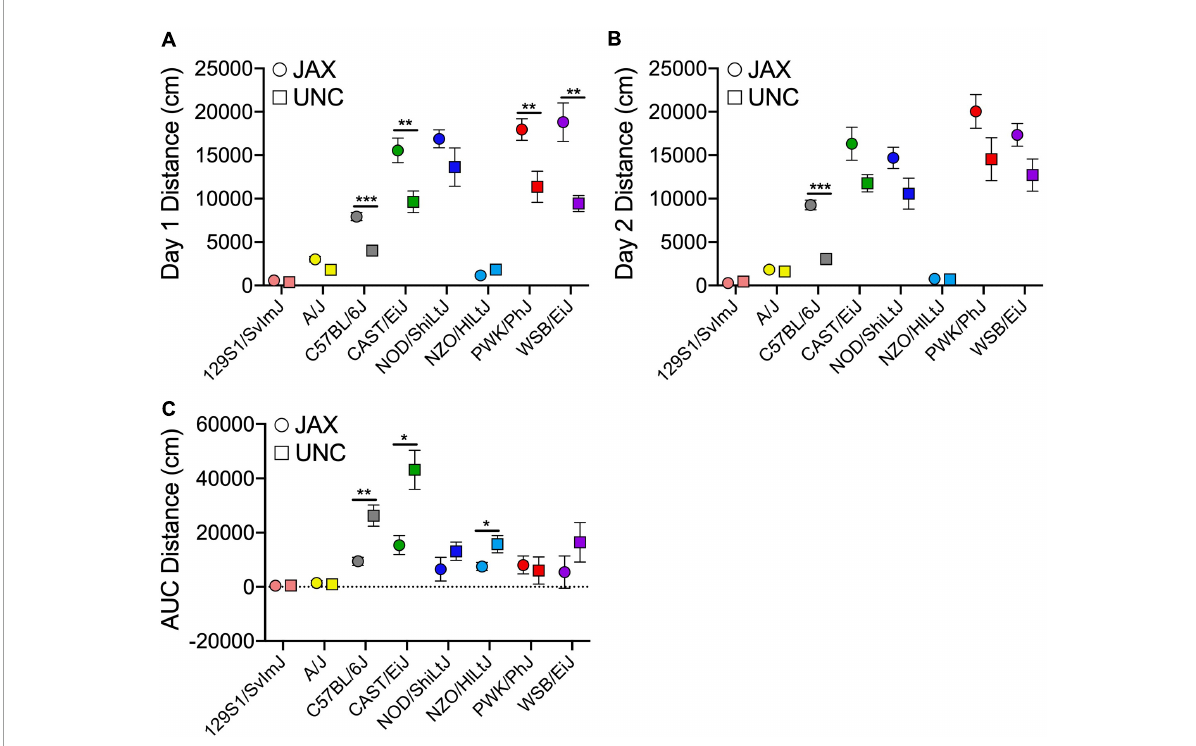
FIGURE5 Founder strain means for distance on Day 1 (A) and Day 2 (B) and sensitization AUC (C) measured at JAX (circles) and UNC (squares). Error bars are standard error of the mean. * p < 0.05, ** p < 0.01, *** p < 0.001.